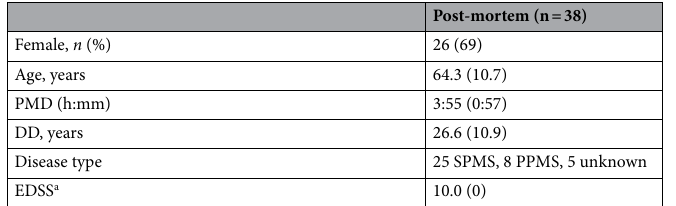
Table 1. Demographic and clinical measures. Description of demographic and clinical characteristics for the post-mortem (left) and in-vivo (right) cohorts. All values represent means and SD, unless otherwise denoted.